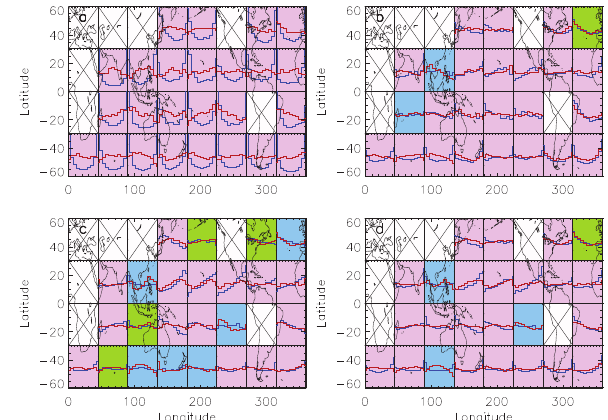
Fig. 4. Talagrand diagrams of the 0–700m temperature for the lagged (blue) and bred (red) initialized ensembles for lead times of (a) one month, (b) 2–4 months, (c) 6–12 months, (d) one year. His- tograms are averaged over the grid cell underneath each histogram (4 ◦ × 8 ◦ grid from 60 ◦ S to 60 ◦ N). The shading of the boxes indi- cates which ensemble is closer to a flat distribution: lagged (blue) or bred (pink) initialized ensemble, or a similar dispersion (green).